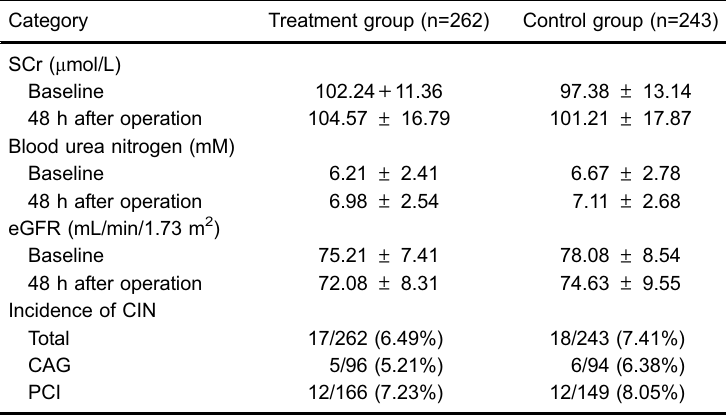
Table 2. Evaluation of contrast-induced nephropathy in a randomized, controlled